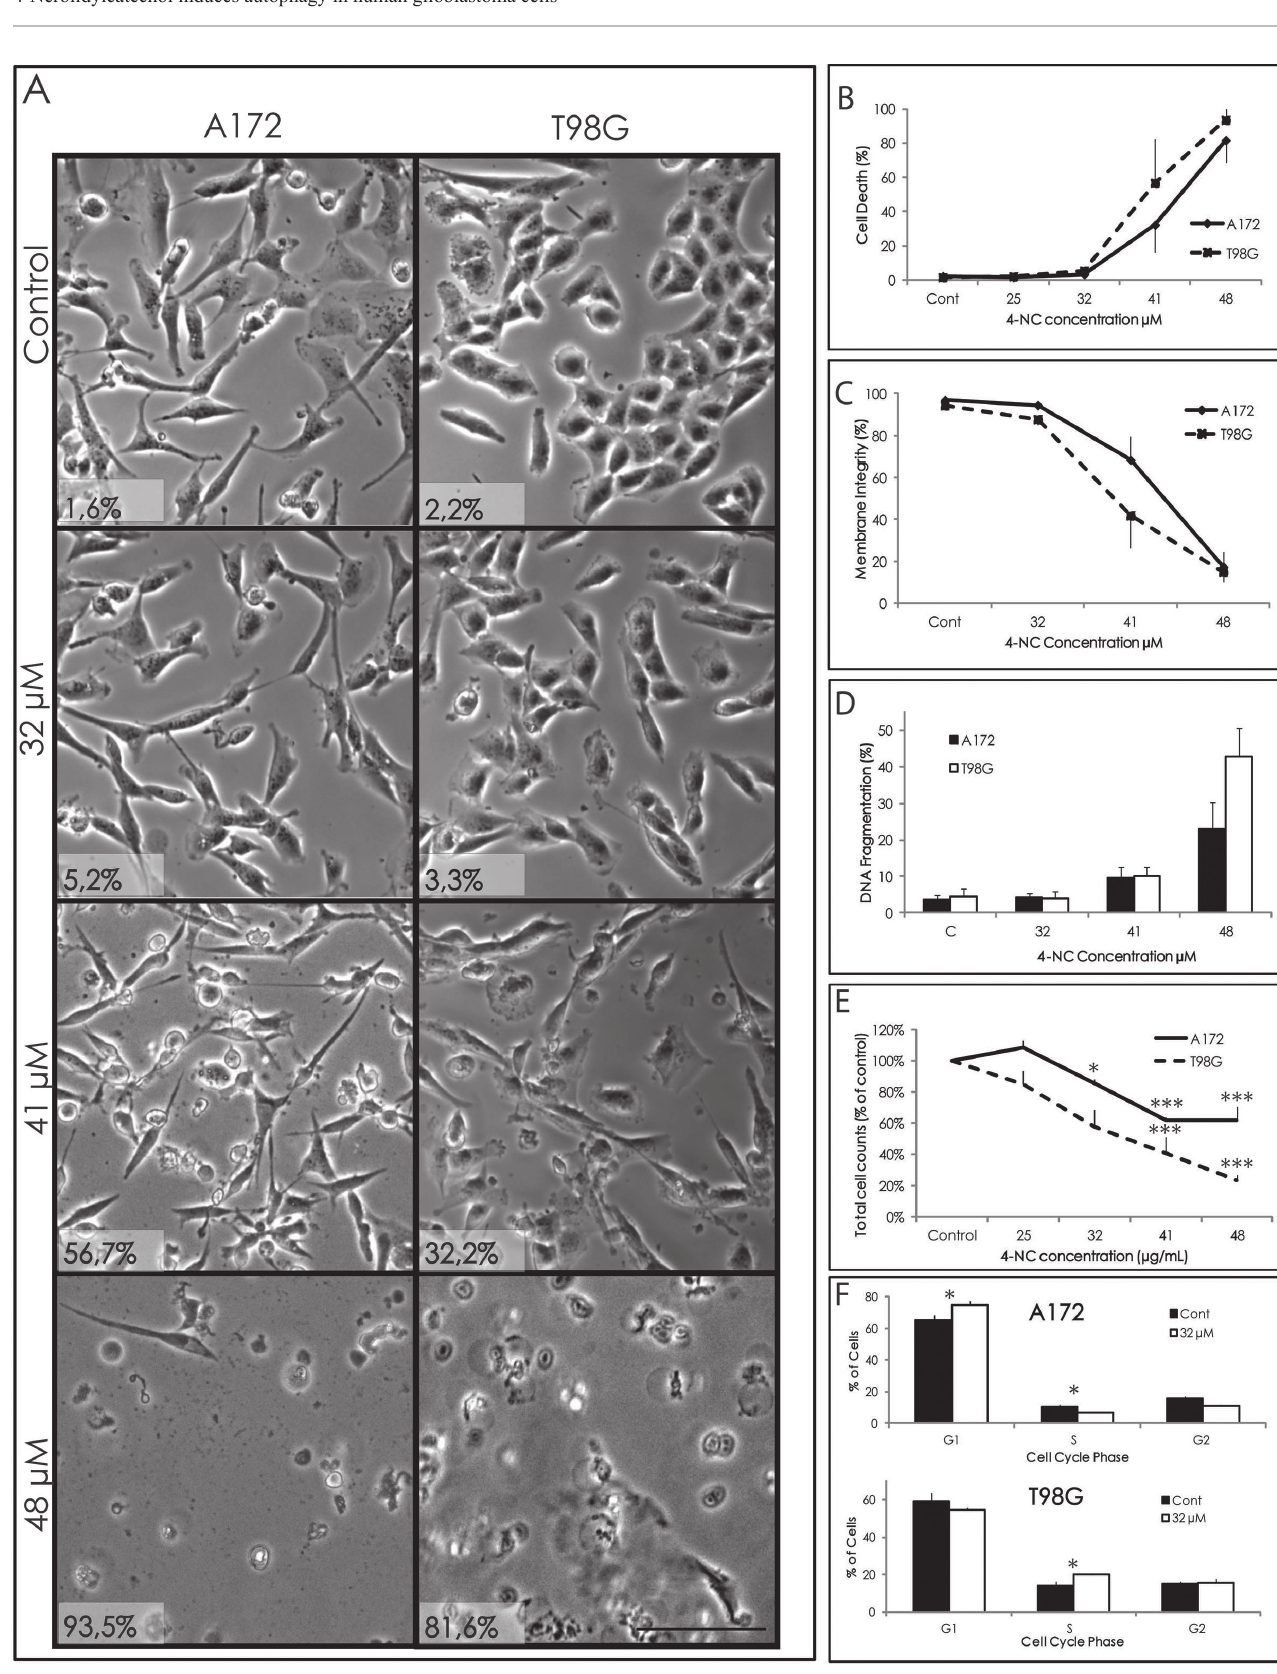
FIGURE 1 - Effects of 4-NC in cytotoxicity, DNA fragmentation and